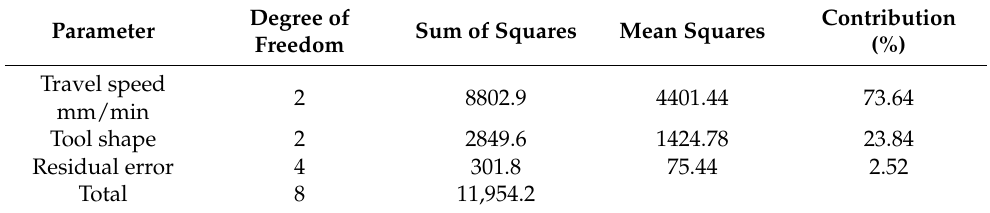
Table 8. ANOVA for Tw.